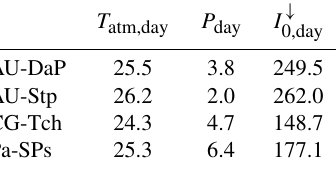
Table 10. Daily average climate measured at the four C 4 grassland sites in this study. T atm,day : daily average temperature ( ◦ C); P day : ↓ : daily average incom- daily average precipitation (mmd − 1 ); I 0,day ing solar irradiance ( Wm − 2 ) . T